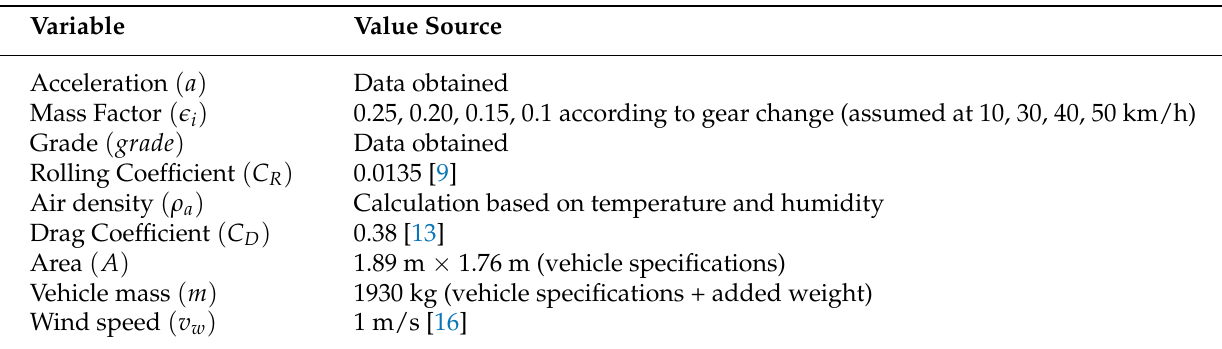
Table 3 shows the values used for the calculation of the VSP parameter. Table 3. Values used for VSP